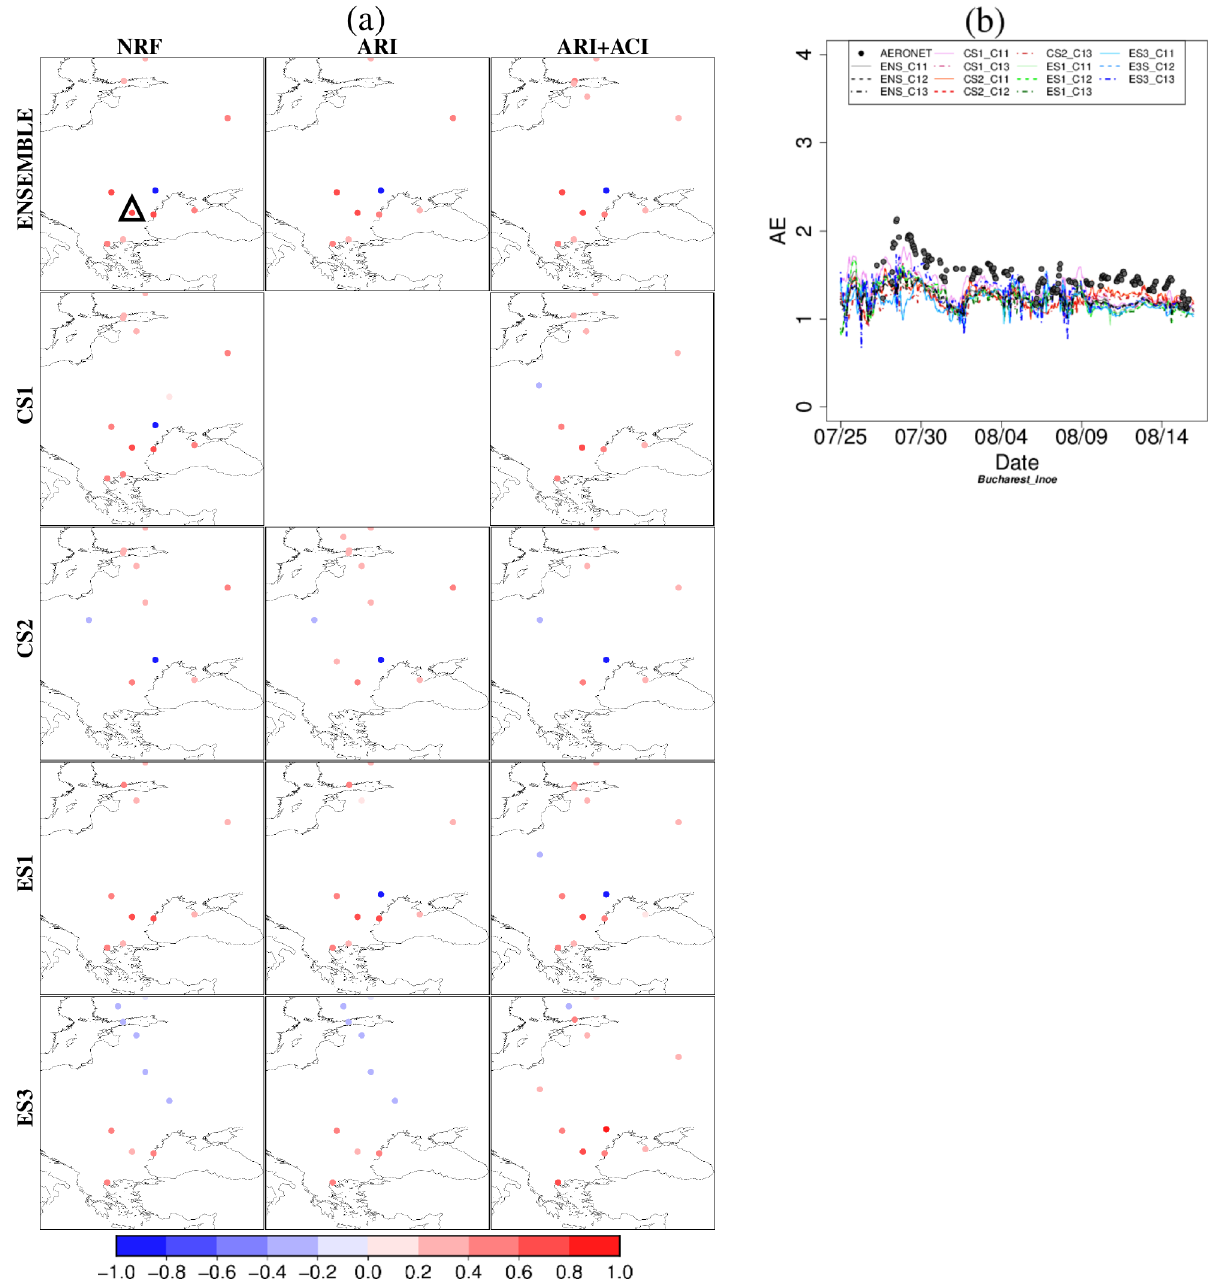
Figure 5. Model–AERONET comparison of AE 440 and 870nm for the Russian wildfires case: (a) temporal correlation values at each AERONET station and (b) temporal series at the Bucharest station (located at black